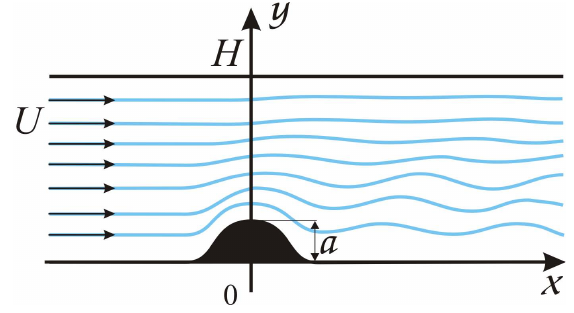
Fig. 1. Scheme of stratified flow over